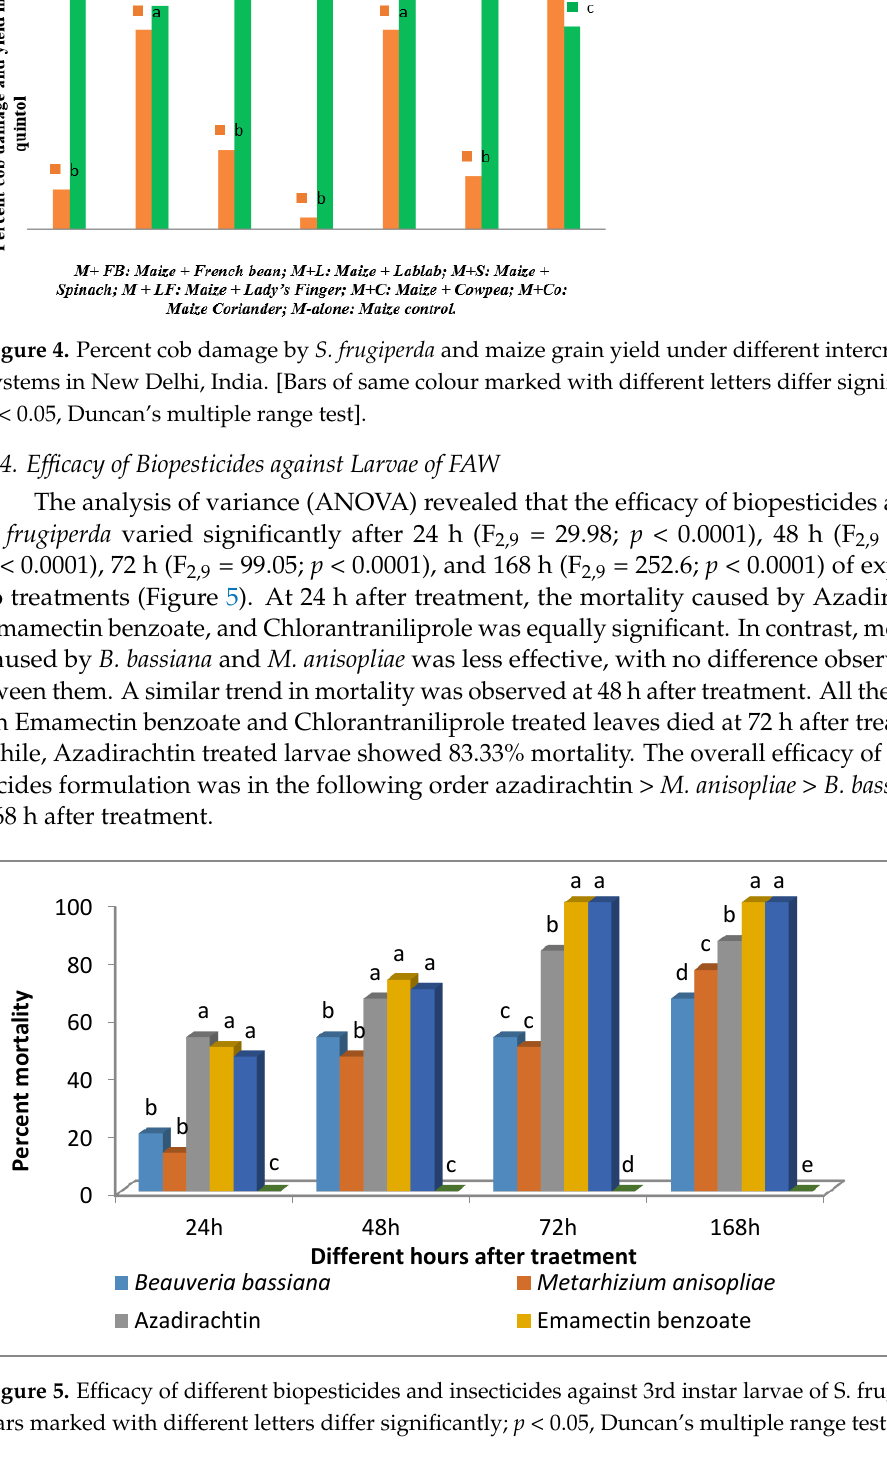
Figure 5. Efficacy of different biopesticides and insecticides against 3rd instar larvae of S. frugiperda . Bars marked with different letters differ significantly; p < 0.05, Duncan’s multiple range test .